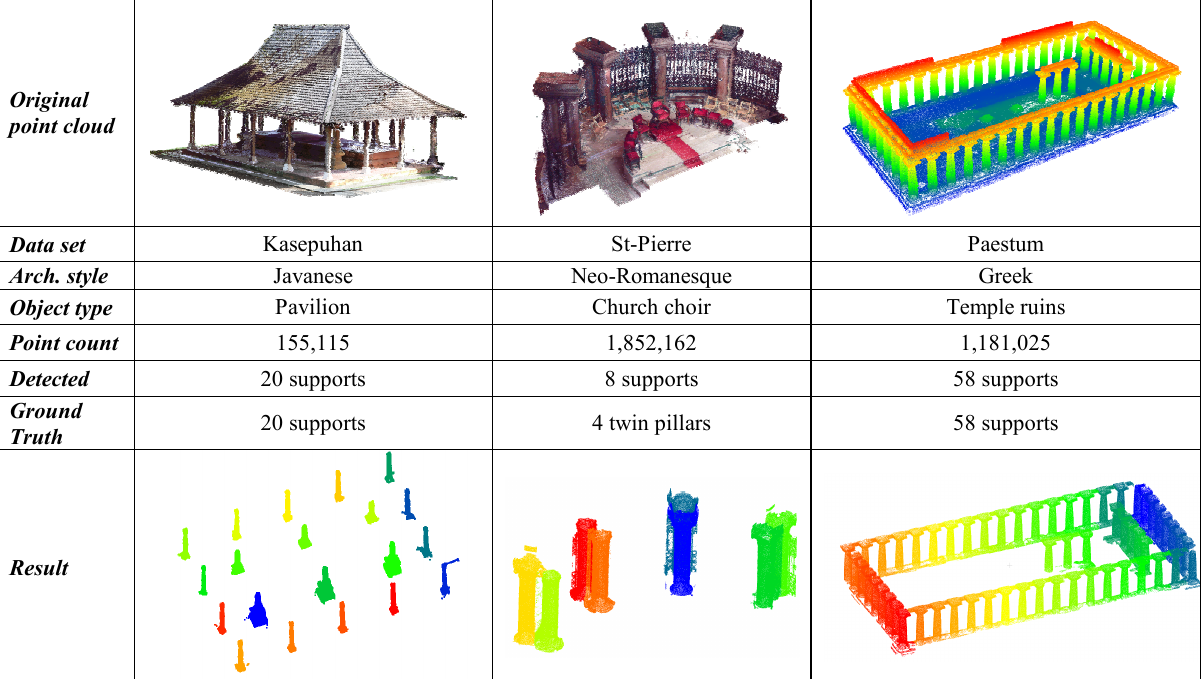
Table 1. Comparison of the results of the segmentation part of the algorithm on the three available data sets. The resulting segmented clusters are displayed in random colours denoting one cluster for each colour.